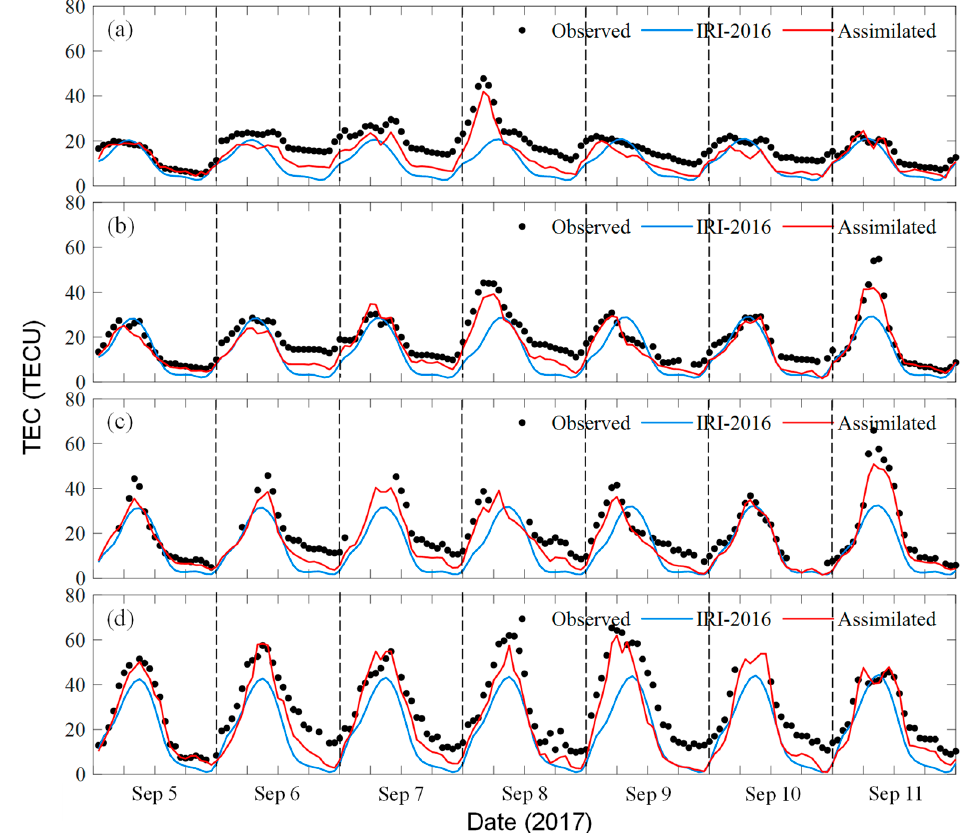
Figure 9. Comparisons of TEC obtained from the GNSS observation (black), from the IRI-2016 model (blue), and from the assimilated method of the improved ensemble Kalman filter (red) at different stations. Shown are the comparisons for a 7-day period from 5 September 2017 to 11 September 2017. ( a ) GAMG-C01; ( b ) JFNG-C01; ( c ) LHAZ-C01; ( d ) CMUM-C01.